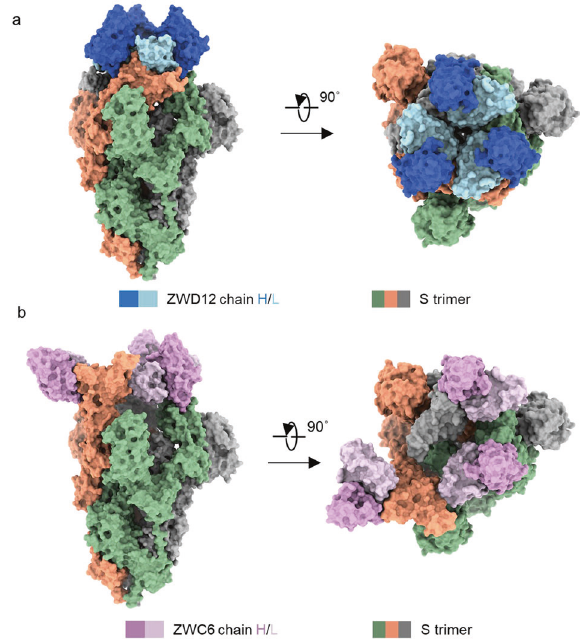
Fig. 5 Cryo-EM complex structures of nAbs with the SARS-CoV-2 S protein. The domain-colored cryo-EM structures of the SARS-CoV-2 S protein in complex with ZWD12 ( a ) or ZWC6 ( b ) Fab, viewed along two perpendicular orientations. The heavy and light chains of ZWD12 and ZWC6 are colored blue, cyan, violet, and pink, respectively. The three protomers of the S protein are colored gray, orange, and